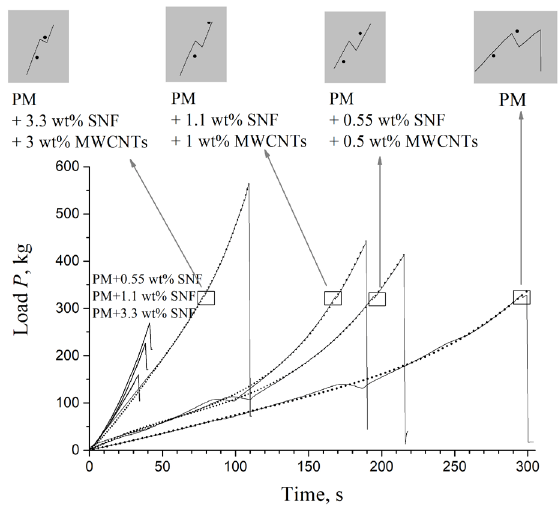
Figure 8 Evolution of the applied load overtime of [PM+SNF+MWCNT] samples during the Brazilian